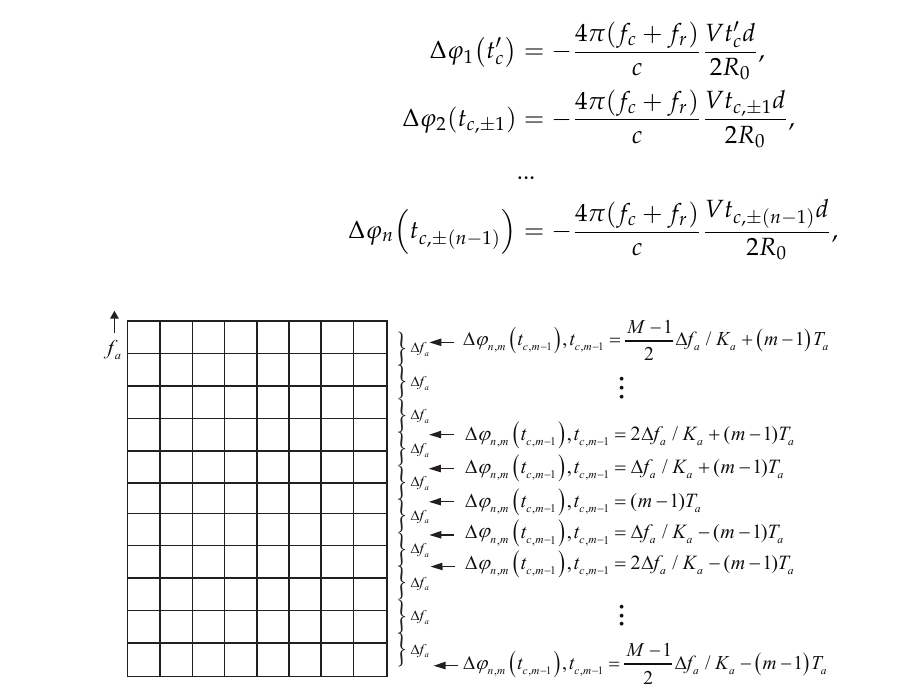
Figure 5. The implementation of the m th residual phase compensation for the n th channel. From Equation (24), the residual phase for each channel is free of channel spacing d n